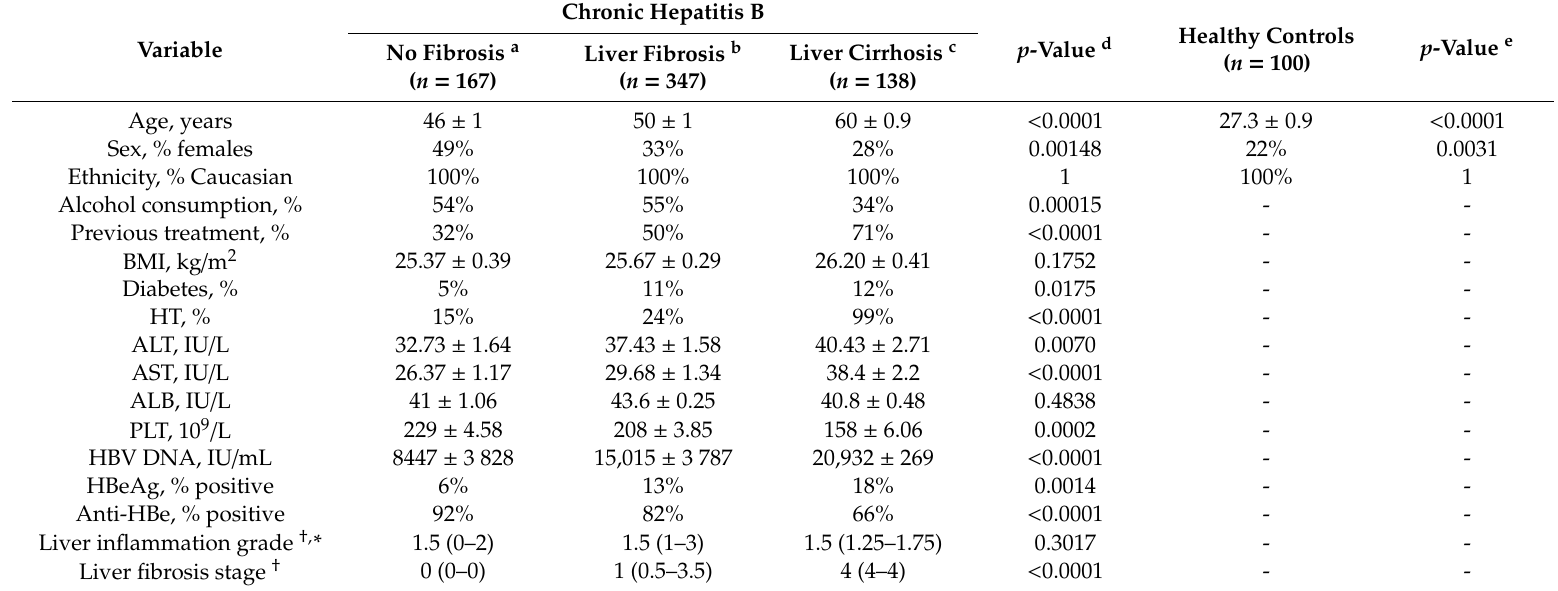
Table 1. Characteristics of chronic hepatitis B patients with liver cirrhosis, hepatic fibrosis, and healthy